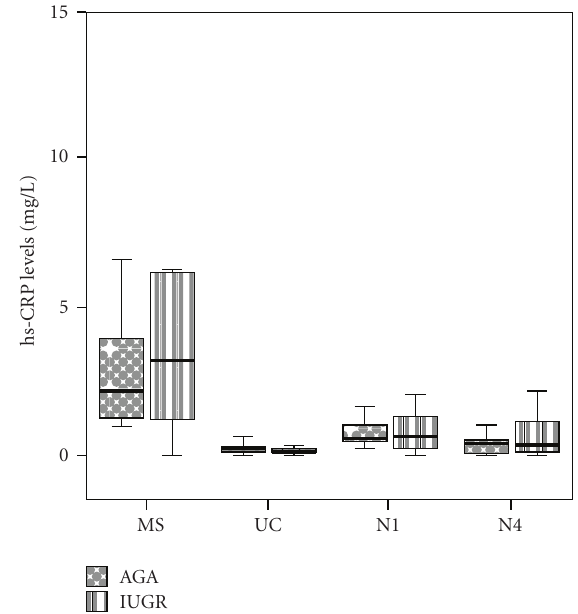
Figure 1: Box and whiskers plot presentation of maternal (MS), fetal (UC), neonatal day 1 (N1), and neonatal day 4 (N4) C- reactive protein (hs-CRP) levels. Each box represents the median concentration with the interquartile range. The upper and lower whiskers represent the range.